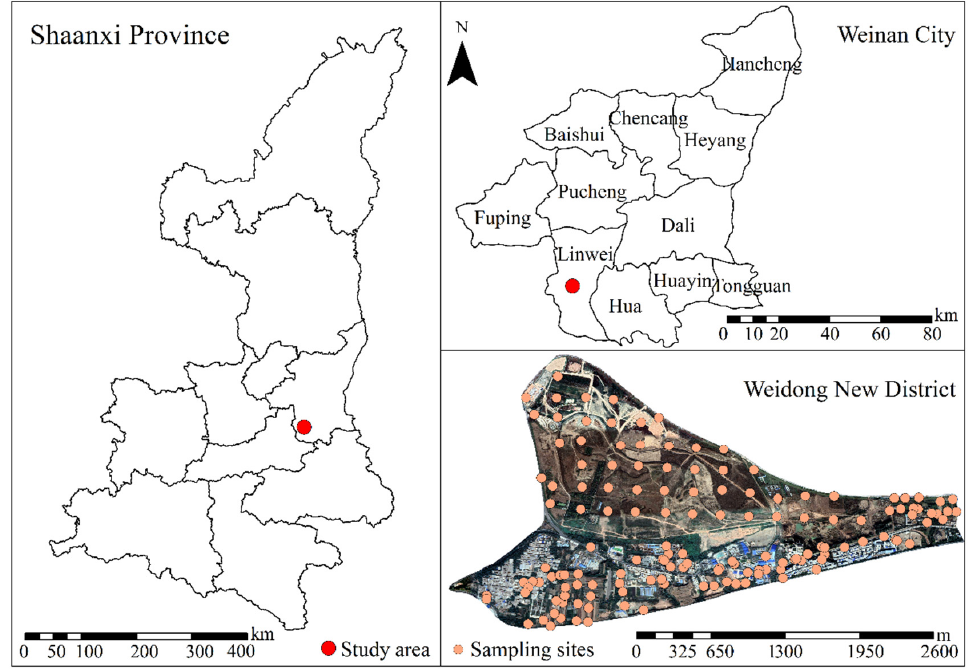
Figure 1. Location of the study area.